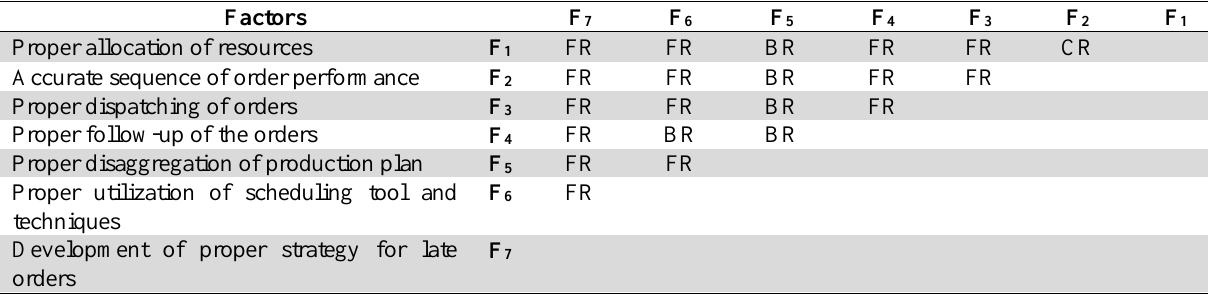
Structural self-interactive matrix